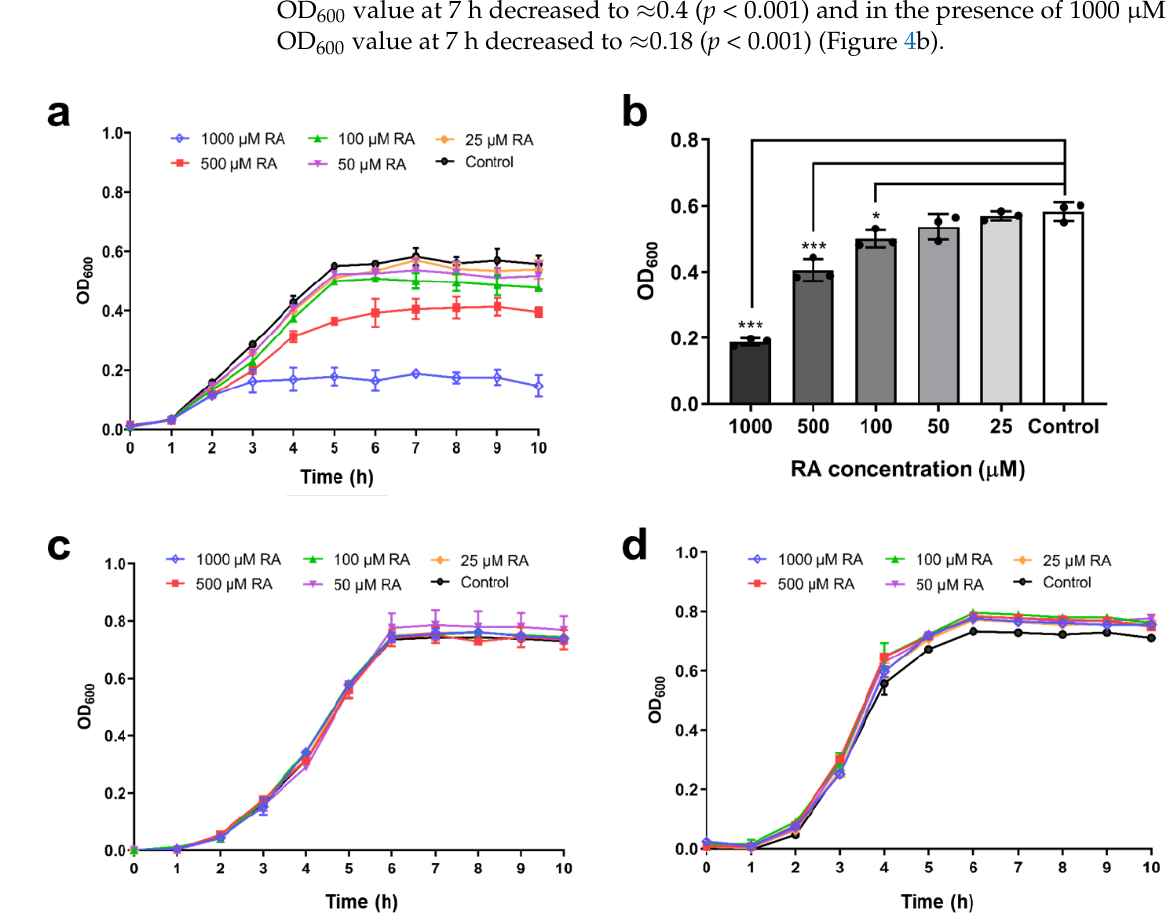
Figure 4. Antibacterial effect of RA. ( a ) Inhibitory effects of RA on V. metschnikovii growth from 0 to 10 h. ( b ) Inhibitory effects of RA on V. metschnikovii growth at 7 h. ( c ) Inhibitory effects of RA on E. coli (KRX) growth from 0 to 10 h. ( d ) Inhibitory effects of RA on E. coli (BL21(DE3)) growth from 0 to 10 h. RA was used at 0, 25, 50, 100, 500, and 1000 μM. * p < 0.05, *** p < 0.001.